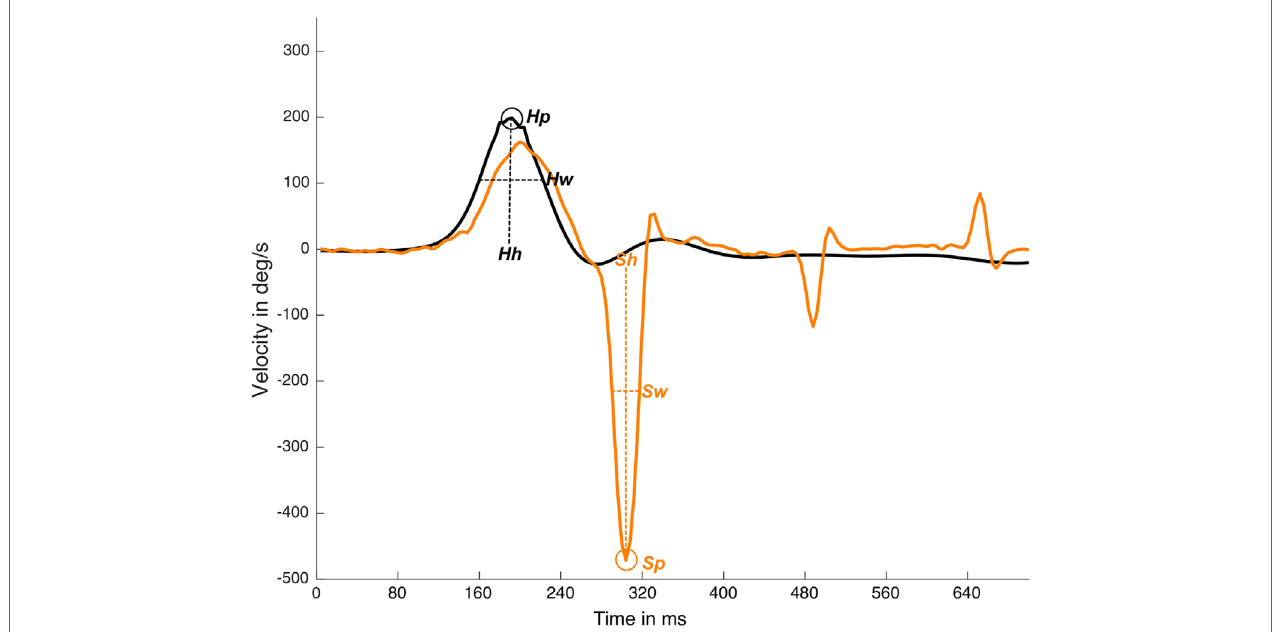
FigUre 1 | Detection and measurements of suppression head impulse paradigm (SHIMP) impulse and response plot. In this real data plot, one head peak was detected (Hp) and one saccadic eye response was detected (Sp). Response latency is defined by Sp time value less Hp time value, Hh is the head response height measured from the head curve baseline to head curve peak, Sh is saccade height also calculated for eye saccadic response. Hw is the head response weight measured as the curve weight at the half of the head curve height, Sw is saccade weight also calculated for eye saccadic response. y -axis is head and eye velocity in deg/s and x -axis is time in samples (with an ~250 Hz sampling frequency), black line is head velocity plot, orange line is eye velocity